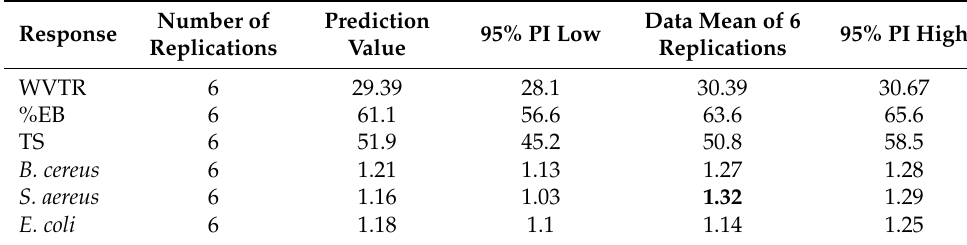
Table 6. Confirmation result: actual vs. predicted value.